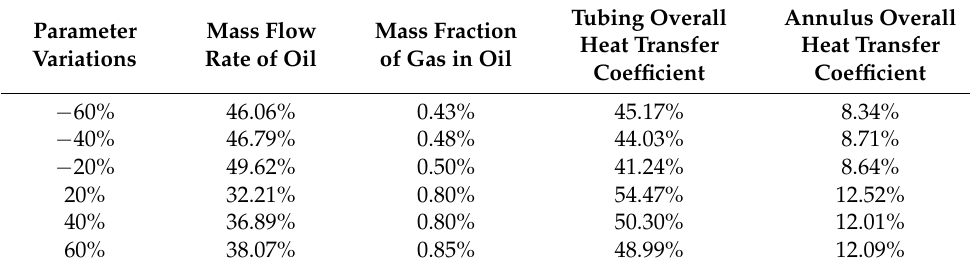
Figure 4. Sensitive analysis for temperature variation inside tubing. Table 3. Influence of factors on temperature within the tubing.